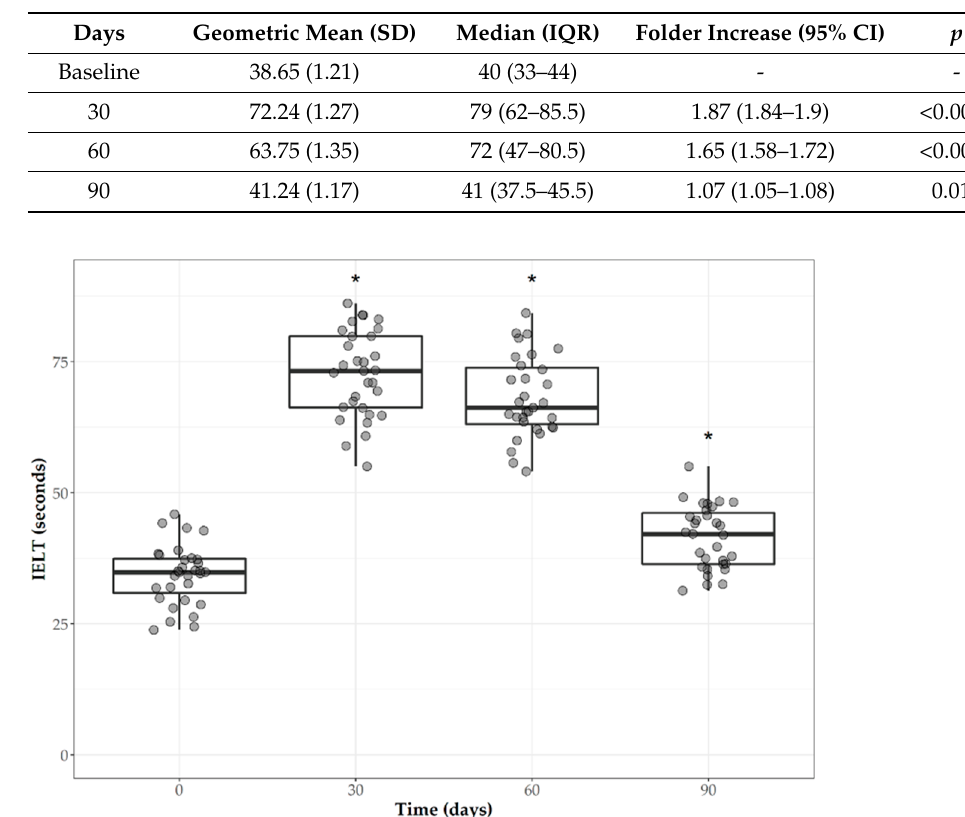
Table 2. IELT mean and median values at baseline and 30, 60, and 90 days after HA injection and relative increase.